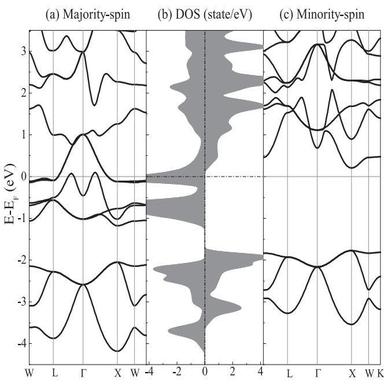
Spin-resolved band structure and density of states of HH-VSbSr in b-phase at optimized lattice constant. The shaded regions represent the total density of states.